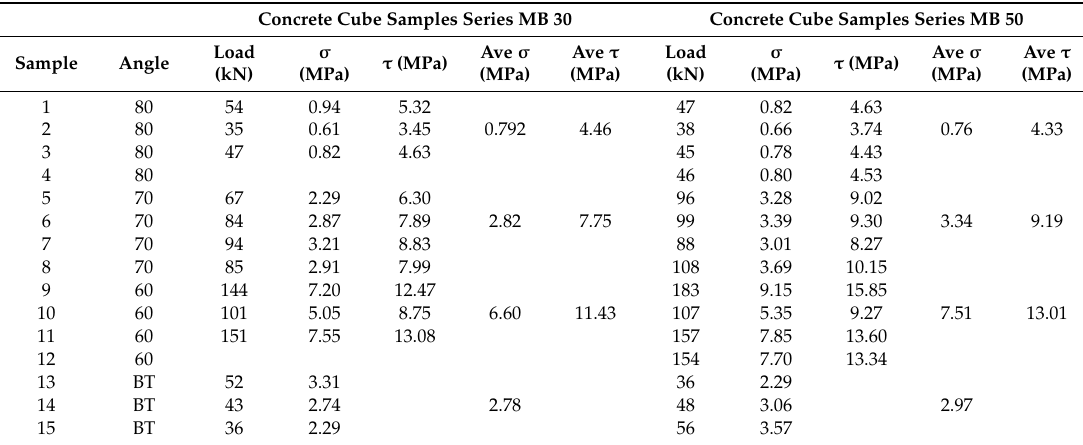
Table 5. Shear test data at fixed angles of 80 ◦ , 70 ◦ and 60 ◦ with respect to σ - axis, and tensile test data for concrete cube samples MB 30 and MB